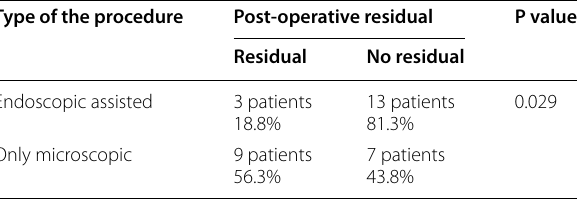
P value is significant if < 0.05